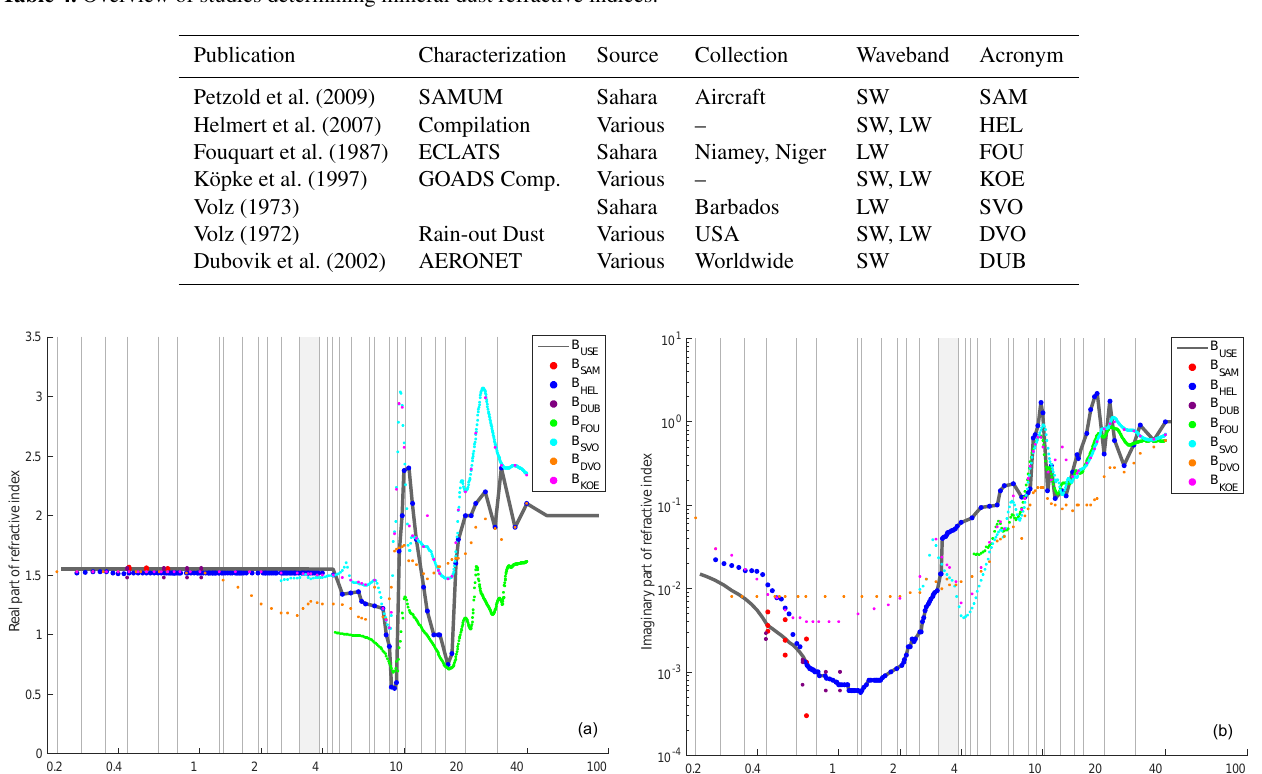
Table 4. Overview of studies determining mineral dust refractive indices.